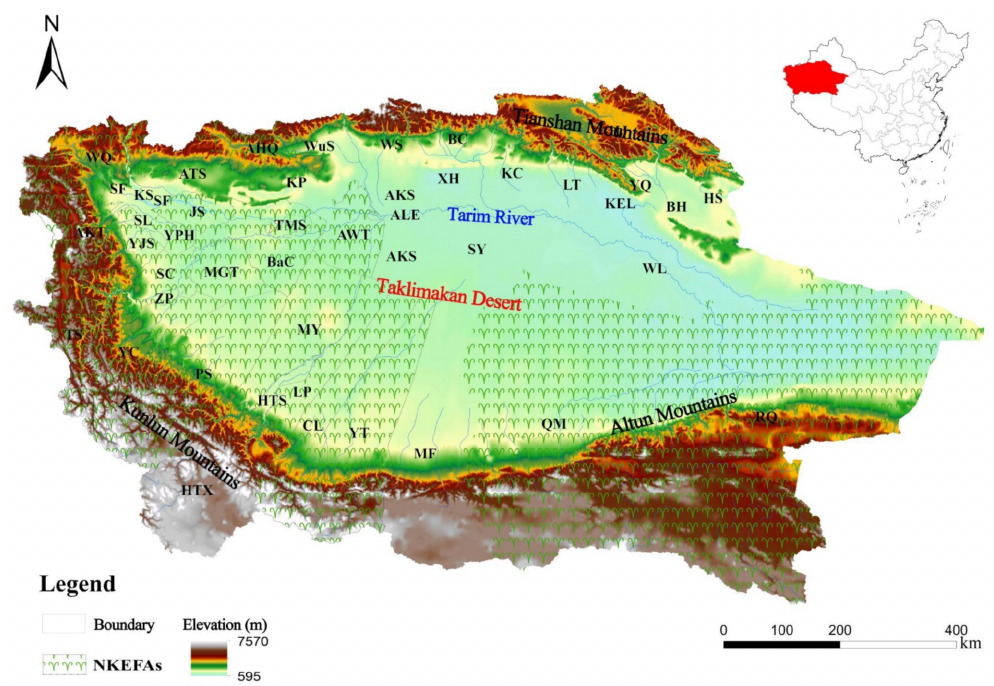
Figure 1. Geographical location of the Taklimakan Desert. This region is one of the core areas of land desertification prevention. Forty-four counties were used for this comparative study. Twenty-one of these counties belonged to national key ecological function areas (NKEFAs), and the other 23 counties belonged to non-NKEFAs. (ALE: Alaer; SL: Shule; BH: